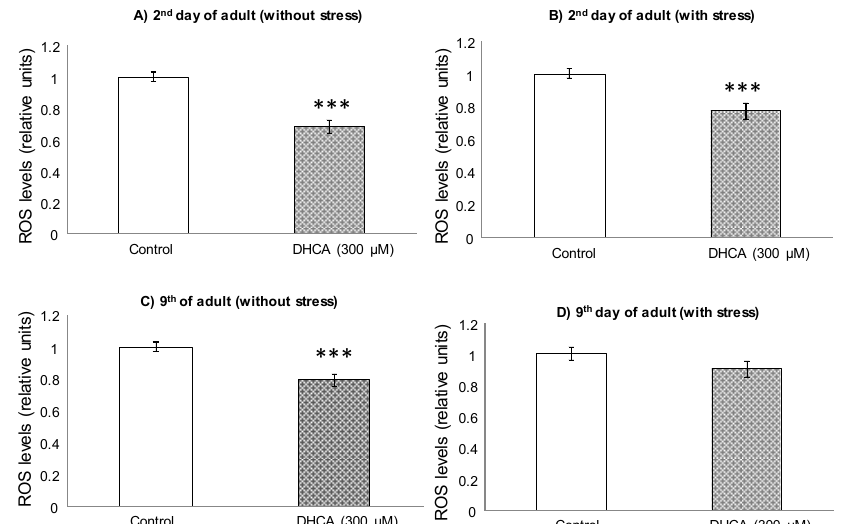
Figure 5. Relative intracellular levels of ROS, determined with DCFH-DA, in C. elegans on days 2 and 9 of adult, cultivated in the presence or absence of DHCA (300 μ M), not submitted ( A and C ) and submitted to thermal stress ( B and D ). The results are standardized with respect to control and represent the mean ± SEM. The statistical significance was calculated using ANOVA (*** p < 0.001).